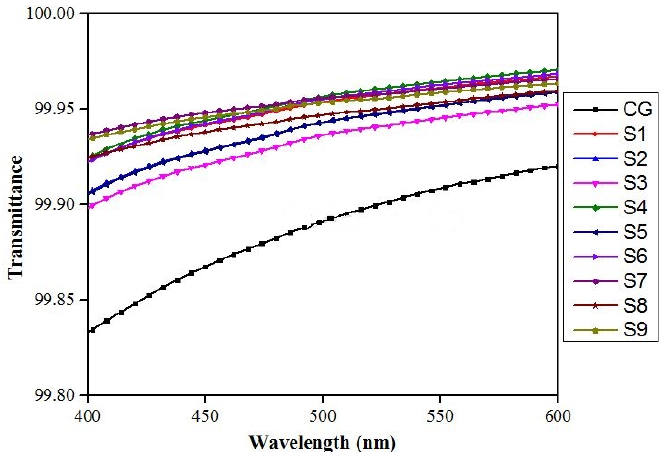
Figure 4. Transmittance of all formulations (S1, S2, S3, . . . , S9), along with commercial gel (CG) in the visible range.